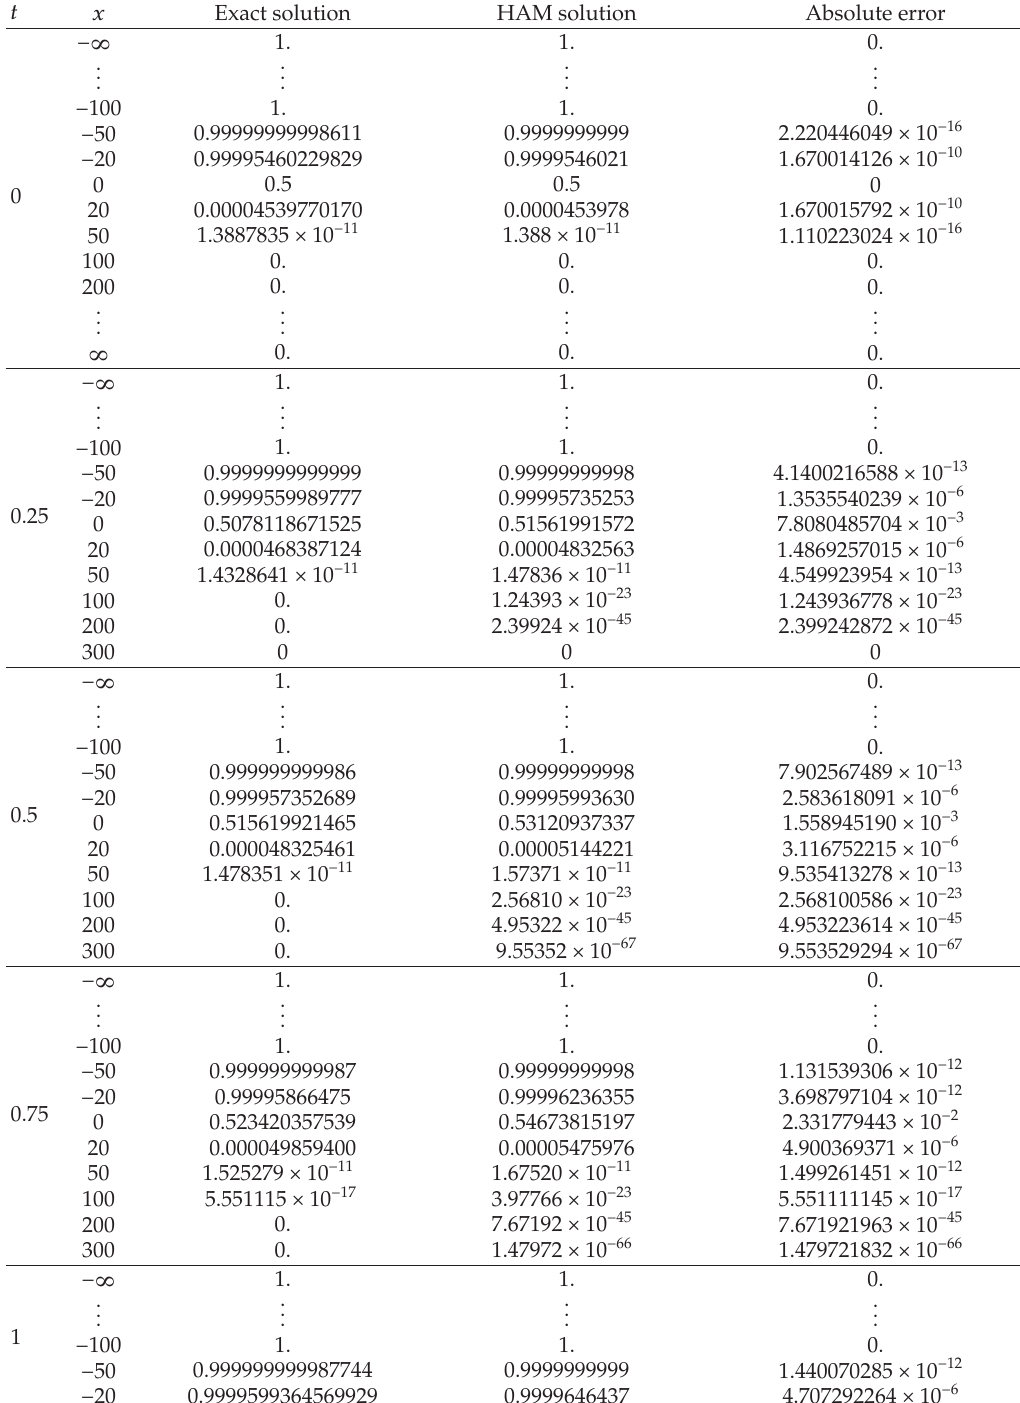
Table 2: Comparison of the HAM solution with exact solution when ħ (cid:8) − 0 . 5 and t (cid:8) 0 , 0 . 25 , 0 . 5 , 0 . 75 , 1,